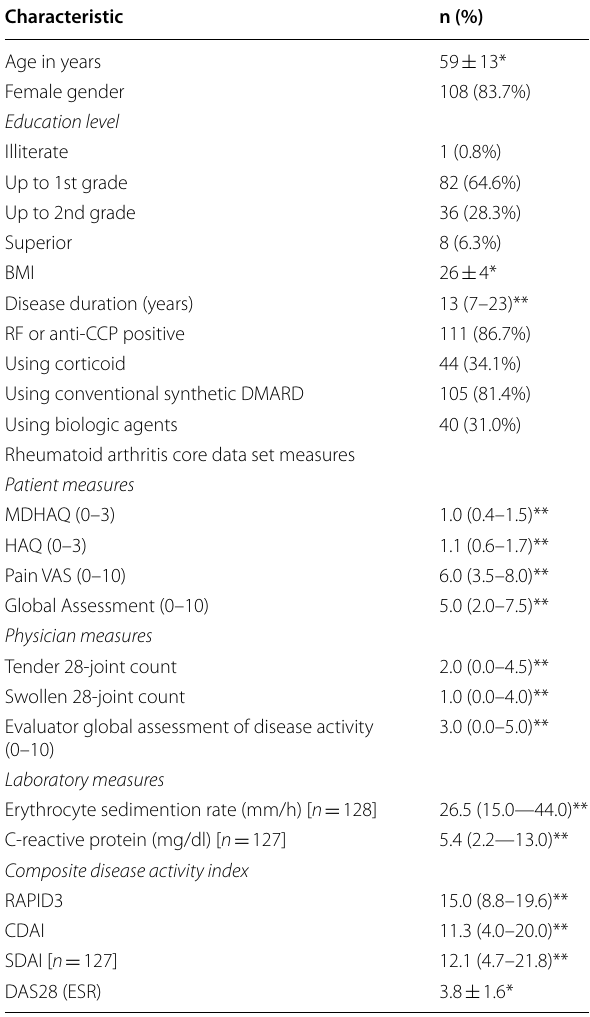
Table 1 Characteristics of the validation study